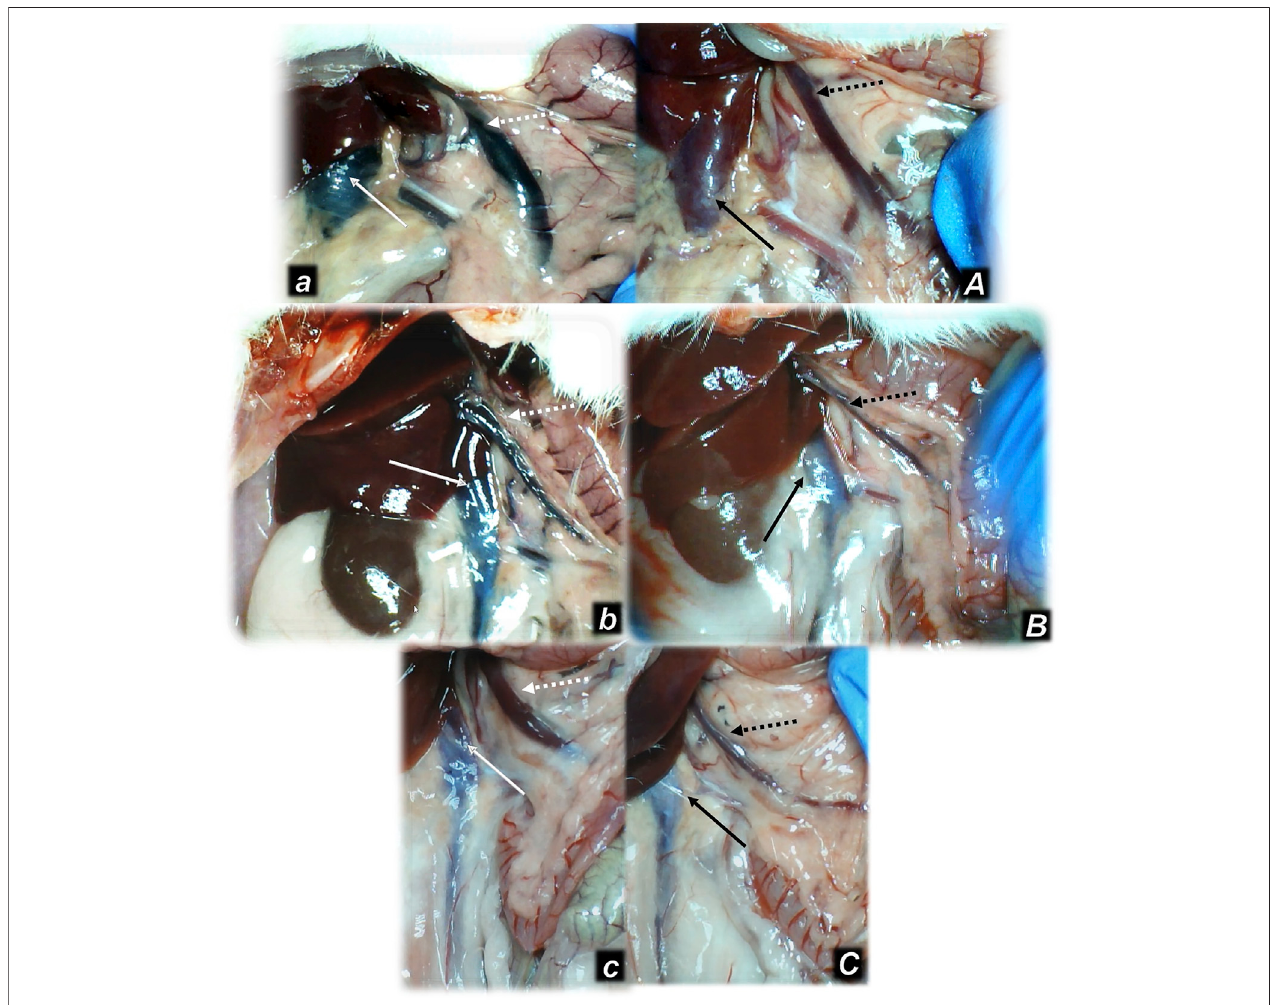
FIGURE 3 | Illustrative presentation of the inferior caval vein (full arrows) and superior mesenteric vein (dashed arrows) after the increased intraabdominal pressure and medication (sc) (saline (5 ml/kg) (white arrows, small letters, congested veins a, b, c ) or BPC 157 (10 ng/kg) (black arrows, capitals, non-congested veins A, B, C ): 25 mmHg (60 min) ( a, A ), 40 mmHg (30 min) ( b, B ), and 50 mmHg (30 min) ( c, C ). A camera attached to a VMS-004 Discovery Deluxe USB microscope (Veho, United